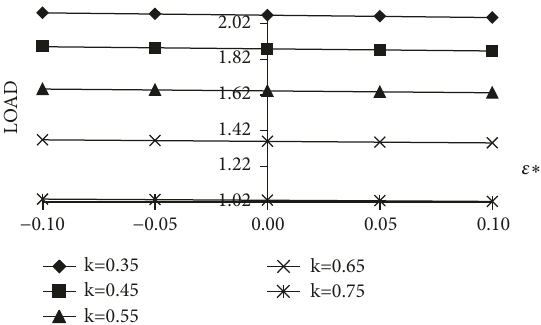
Figure 16: Profile of load with respect to 𝜀 ∗ and